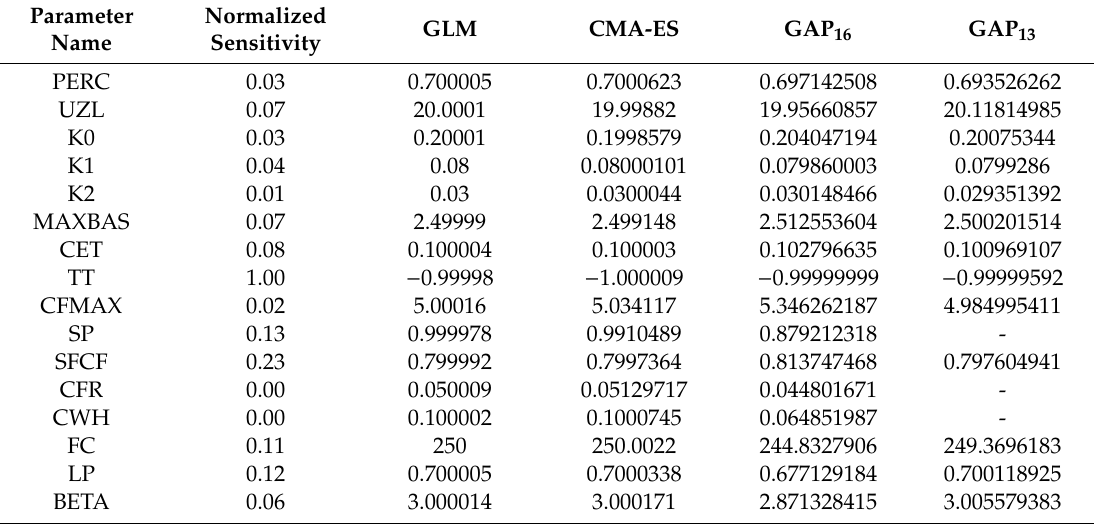
Table 5. The values of the individual parameters determined in the calibration procedure.